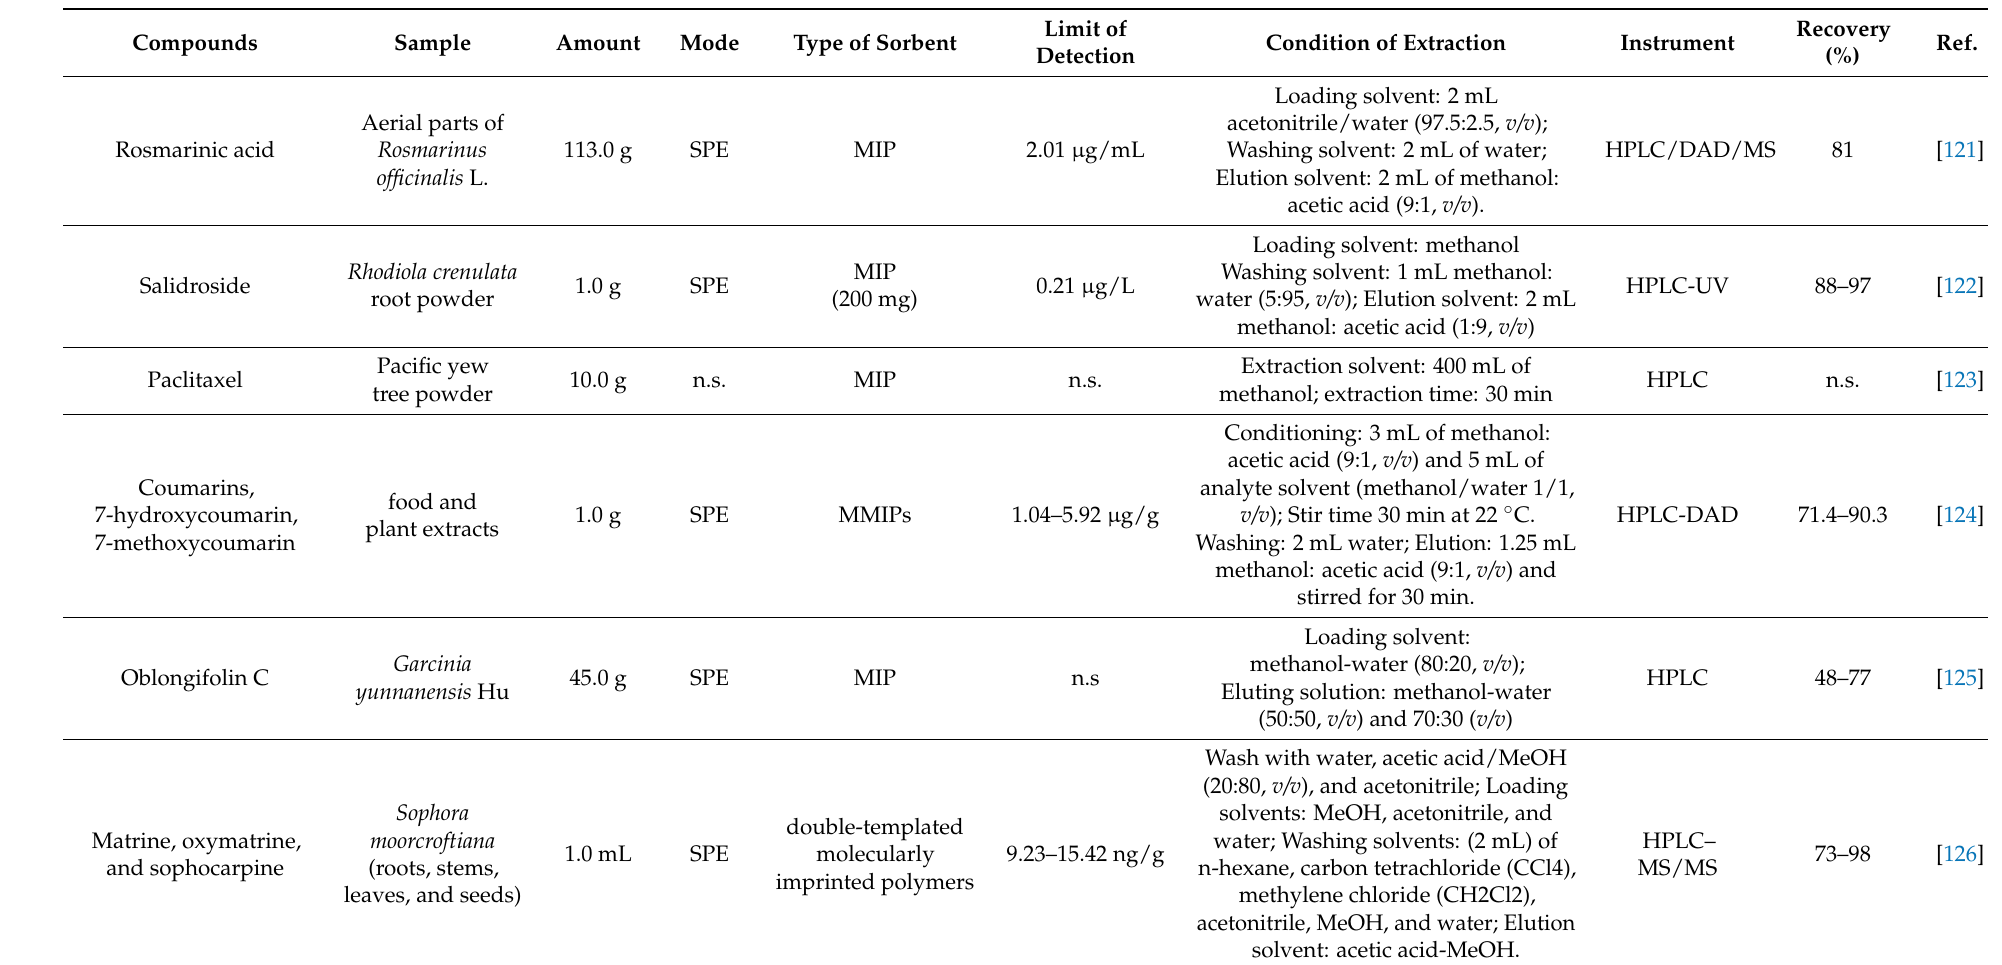
Table 7. Application of MISPE techniques for extraction of several compounds in natural products. Compounds